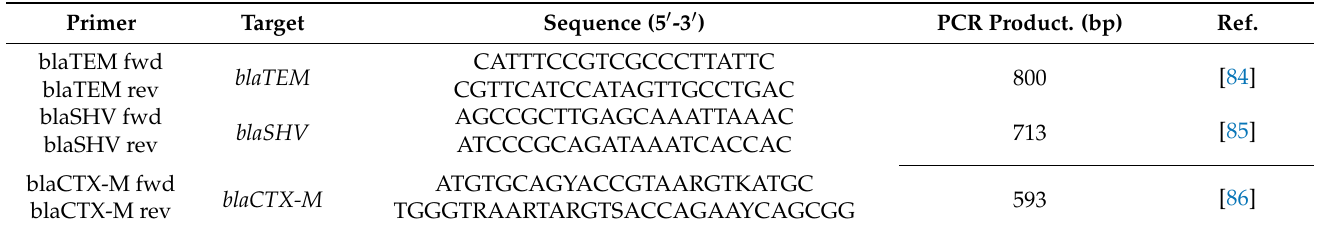
Table 13. List of primers used for detection of extended-spectrum β -lactamase resistance